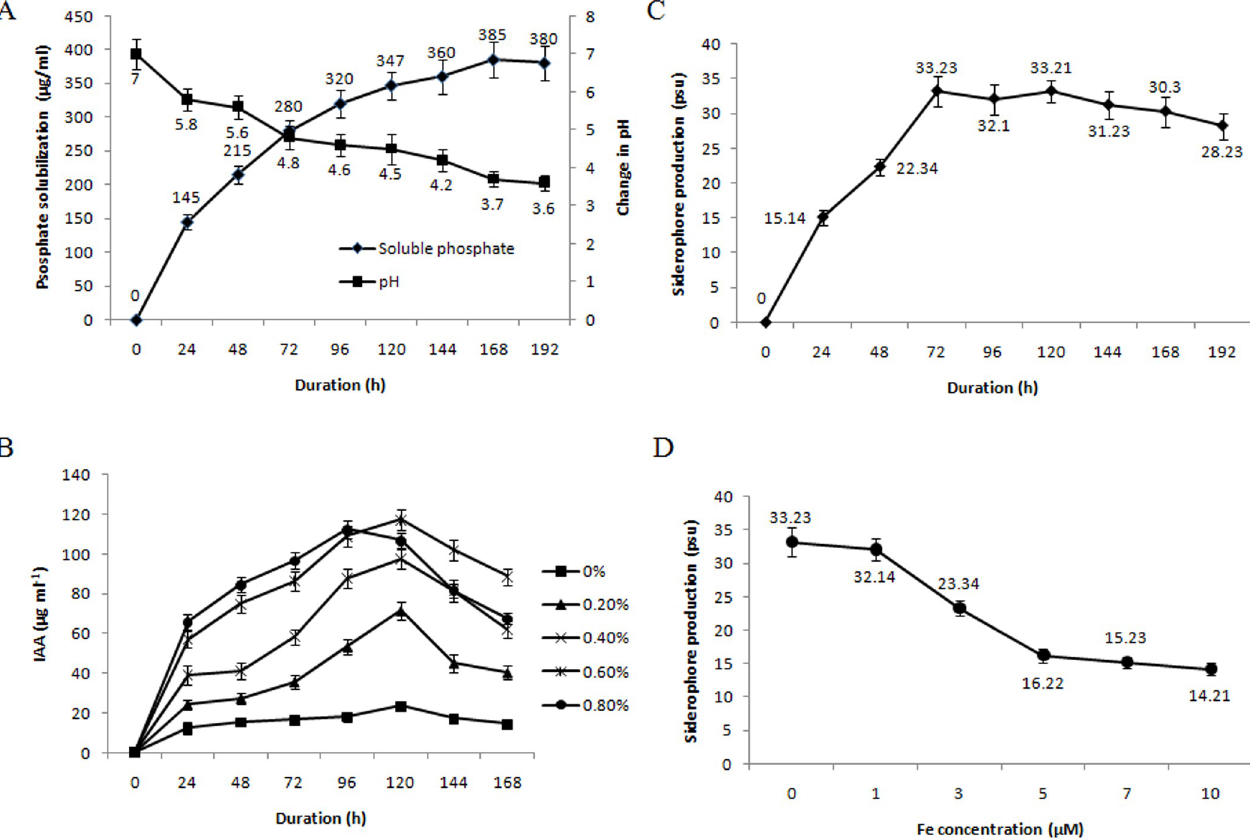
Fig 4. PGP effects of Ld-08. (A) Phosphate solubilization after different time intervals. Soluble free phosphate concentration is given against the primary y- axis, while a change of pH in the culture medium is given at the secondary y-axis. Standard deviations showed as bars. (B) Quantitative estimation of IAA produced by Ld-08 at different L-tryptophan concentrations. (C) Quantitative estimation of siderophore release against growth of bacteria. (D) Effect of iron source on the production of